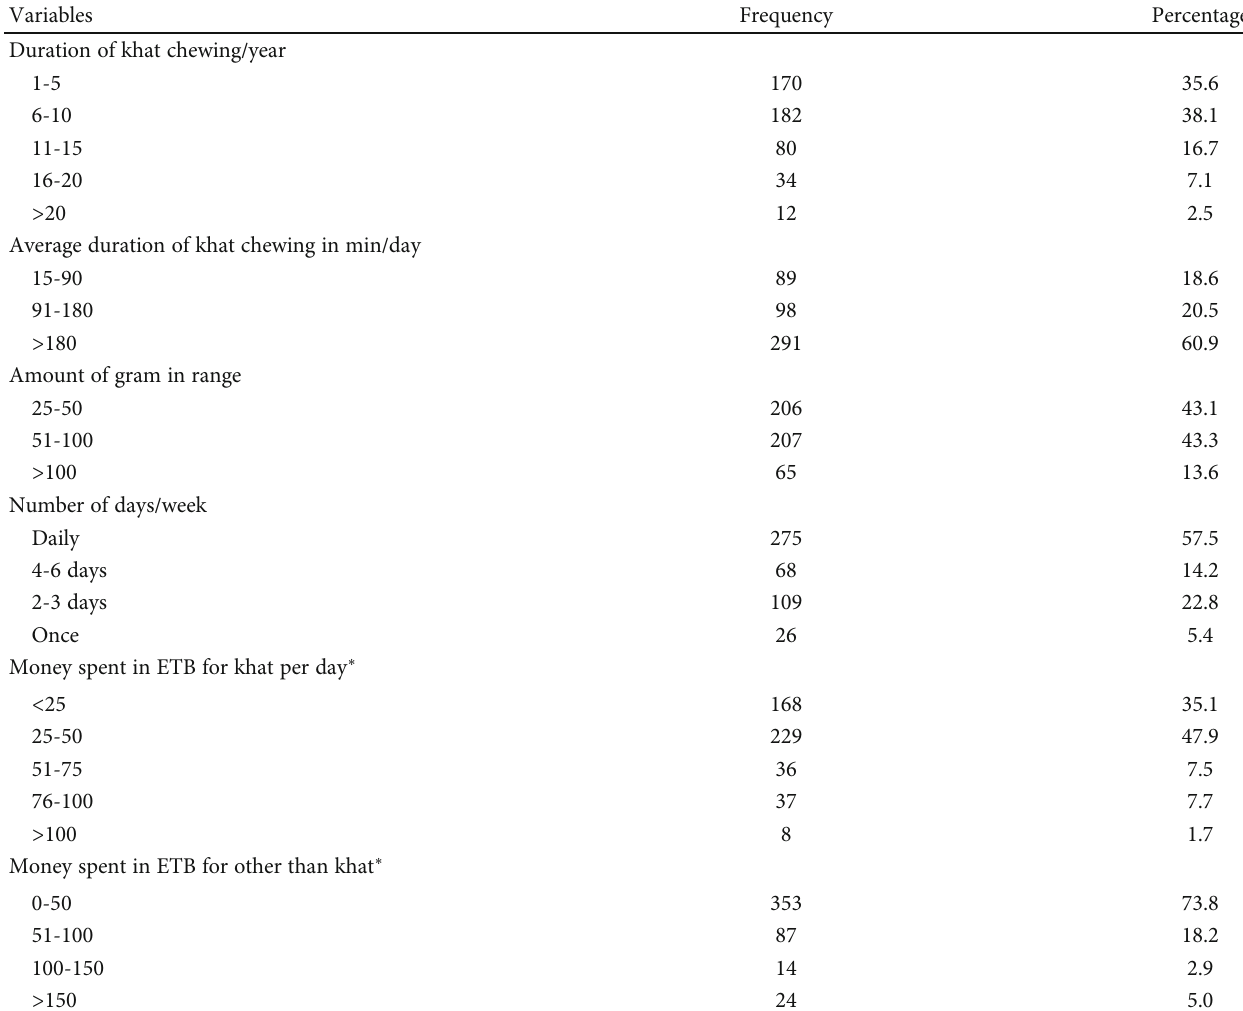
Table 2: Khat chewing behaviors among khat chewers in Amhara region, 2019 ( N = 478